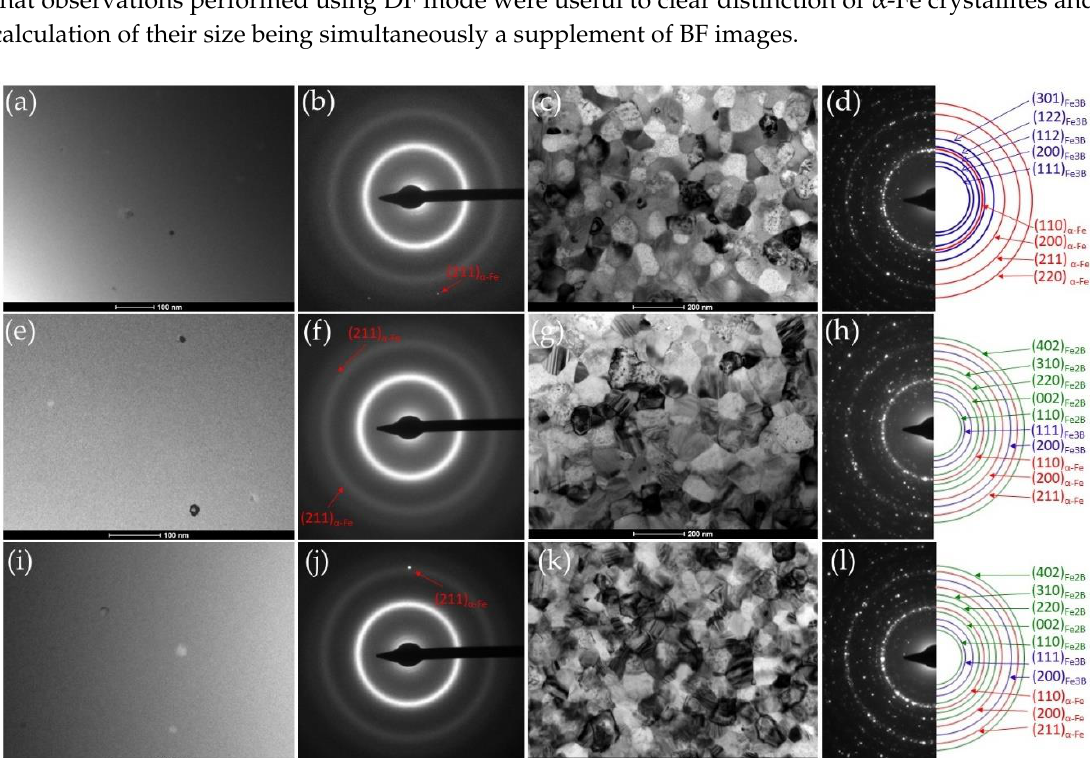
Figure 9. Bright field image, set of dark field images and selected area diffraction patterns of Fe 85.45 Cu 0.55 B 14 annealed at 370 °C. 3.5. Discussion The effect of Cu content and Gibbs free energy of amorphous phase formation ΔG amorph on the crystallization kinetics and magnetic parameters for annealed samples at optimal Ta has been shown in Figure 10. There is a correlation between Gibbs free energy of amorphous phase formation ΔG amorph and crystallization kinetics (Figure 10a). The most negative value of ΔG amorph corresponds to the lowest value of crystallization temperature and to the average E a of α-Fe phase formation. The